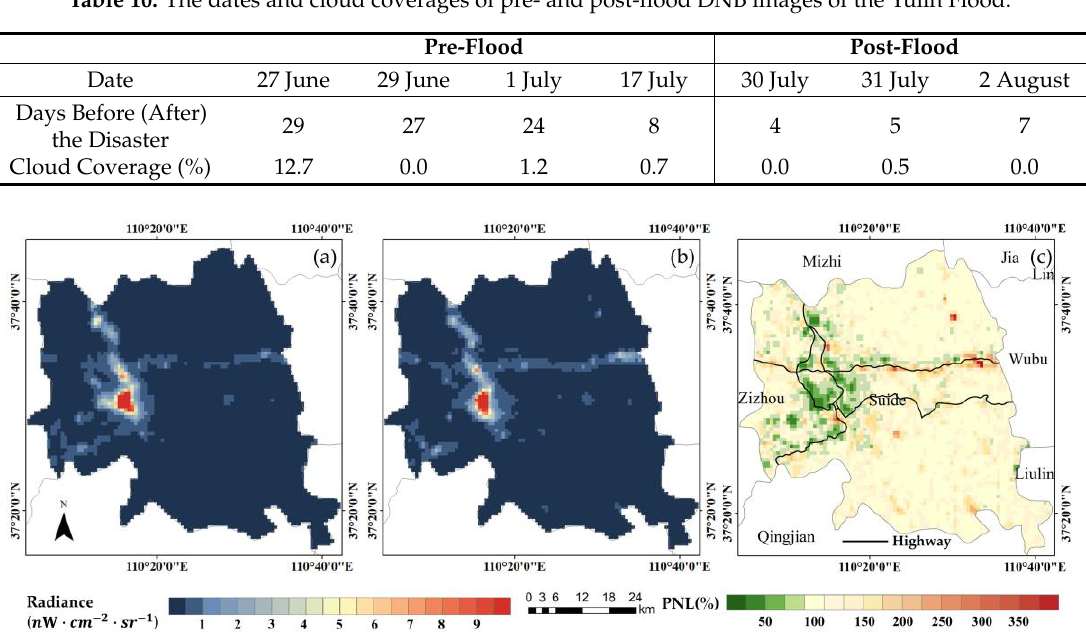
Figure 10. The percentage of cloud coverage in the study areas 10 days after each disaster.